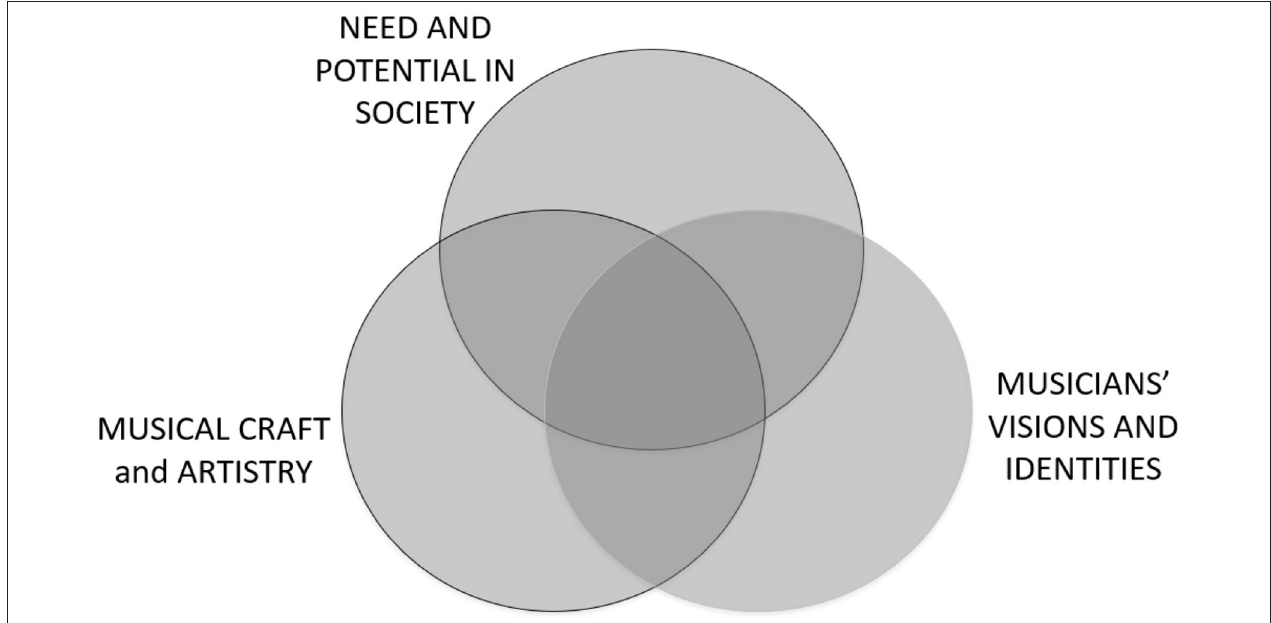
FIGURE 2 | Three essential domains within a contemporary conceptual paradigm for HME.